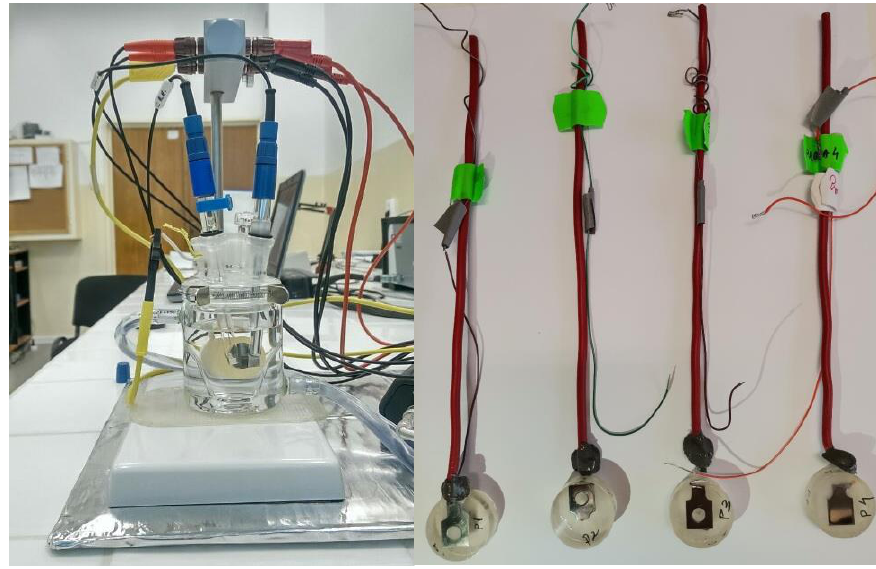
Figure 4. PARSTAT 4000 installation [31] ( left ) and the samples after the corrosion tests ( right ). The SBF solution had a pH of 7.4 at the human body temperature (37 ± 0.5 °C)